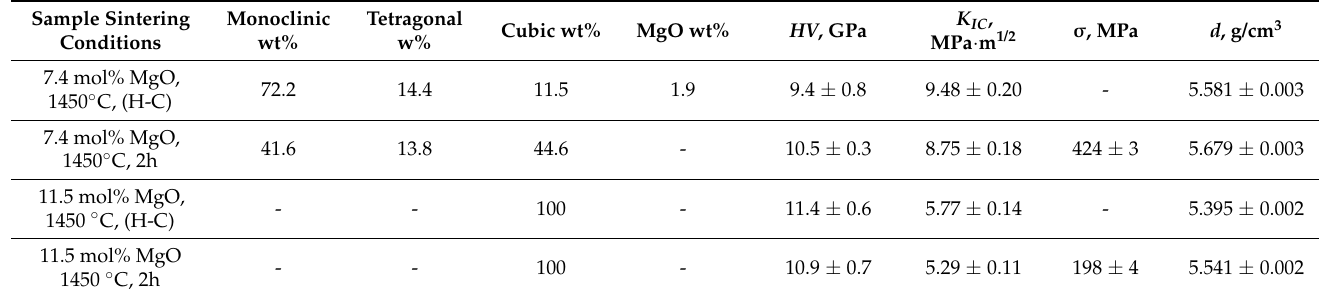
Table 3. Phase composition, hardness (HV), critical stress intensity factor (KIc), strength (σ), and density (d). Sample Sintering Conditions